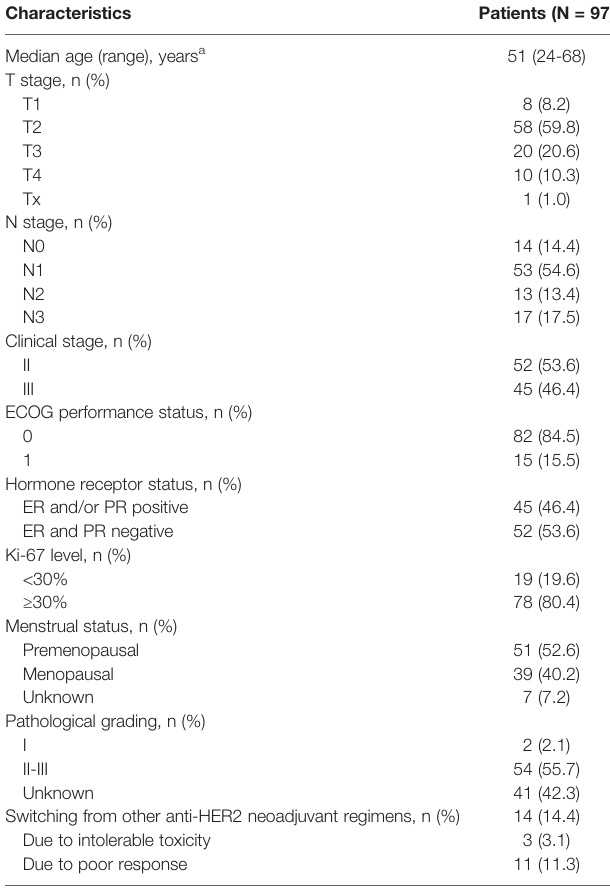
TABLE 1 | Baseline characteristics. Characteristics Patients (N =